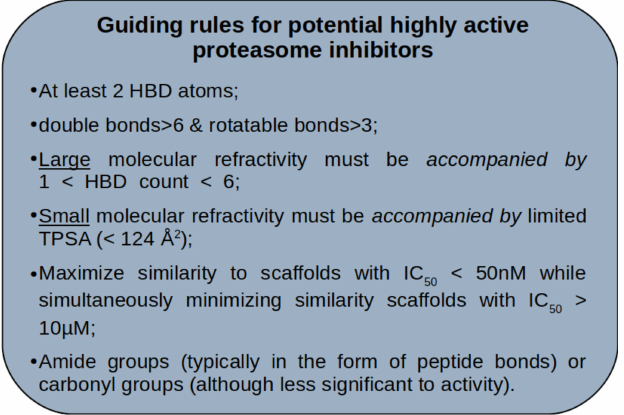
Figure 17. General guidelines for proteasome inhibitors, extracted from the analysis of publicly available inhibition data of the last two